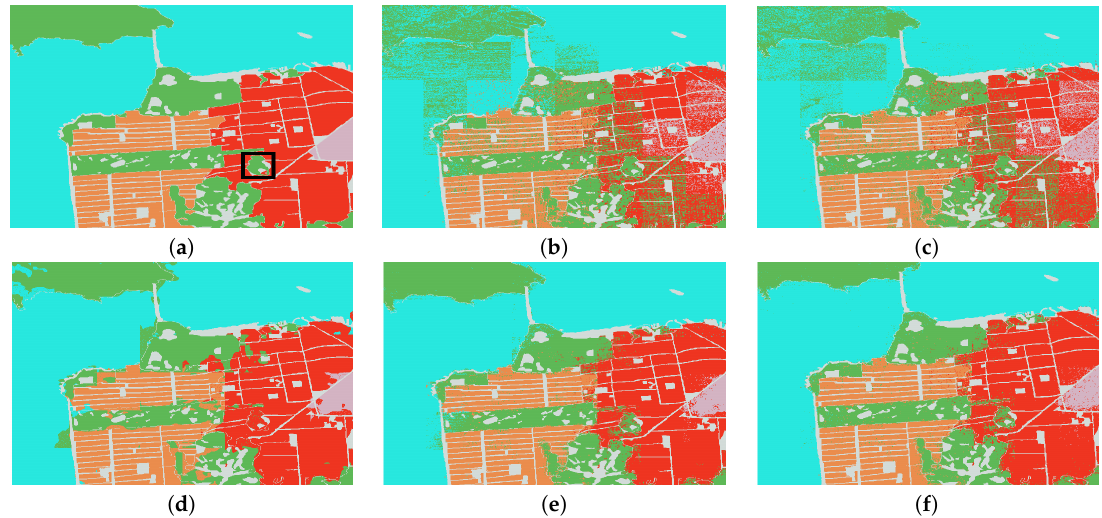
Figure 12. Visual classification of different algorithms on San Francisco dataset. ( a ) GT. ( b ) T3: 81.03%.